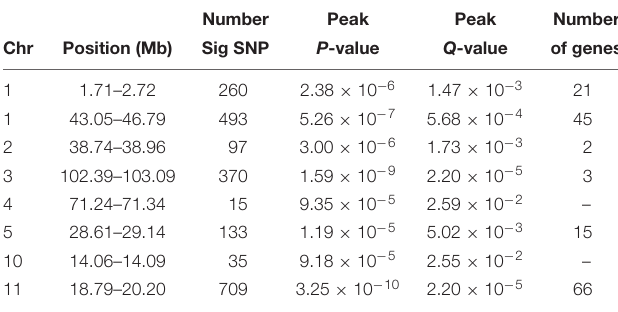
TABLE 1 | Putative selective signatures identified across Egyptian breeds in the hapFLK